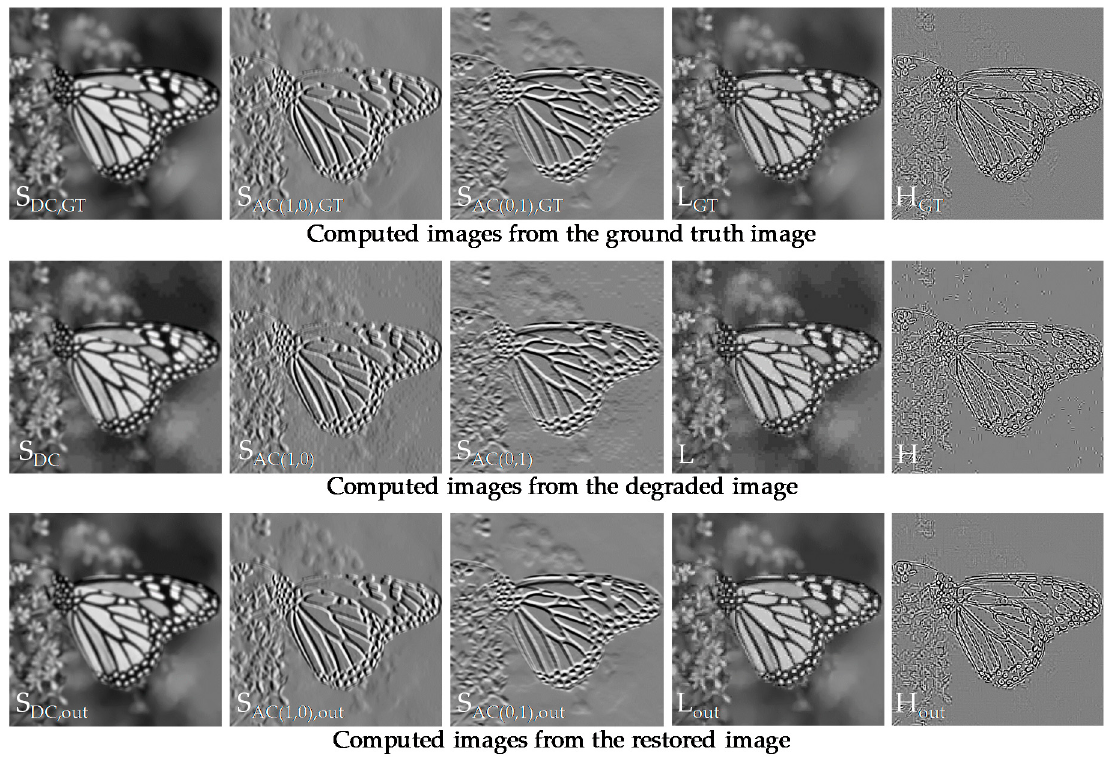
Figure 4. Stepwise restoration results of the SCENet. The first, second, and third columns show secondary images of DC, AC(1,0), and AC(0,1), respectively. The fourth and fifth columns show the LB and HB images, respectively.